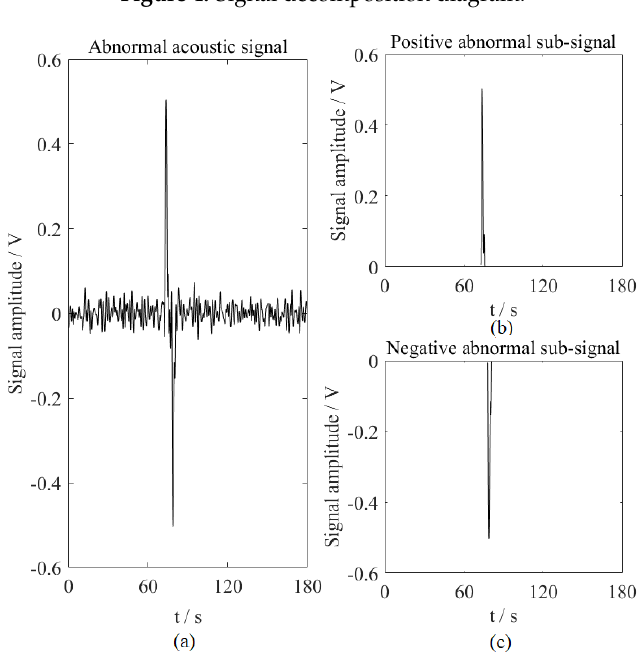
Figure 5. Decomposition example of an acoustic